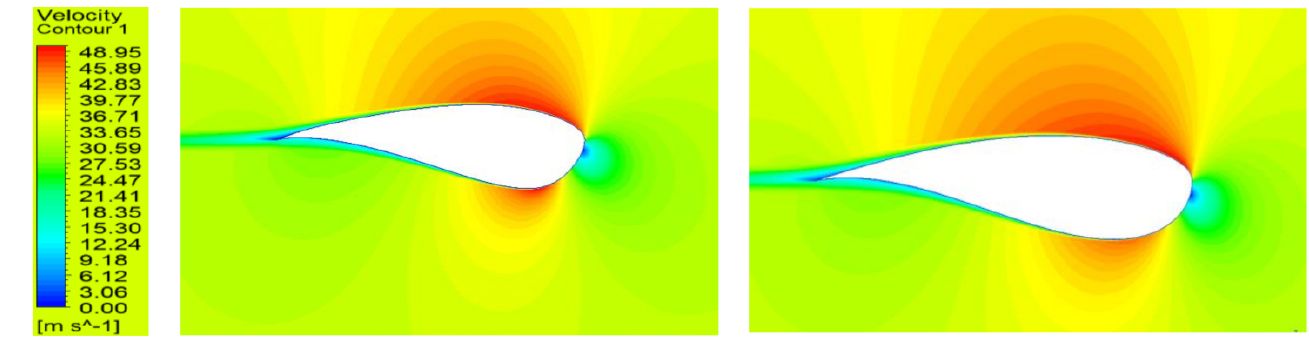
Figure 15. Velocity contour for original ( left ) and the optimized airfoil ( right ) (NREL S-821).